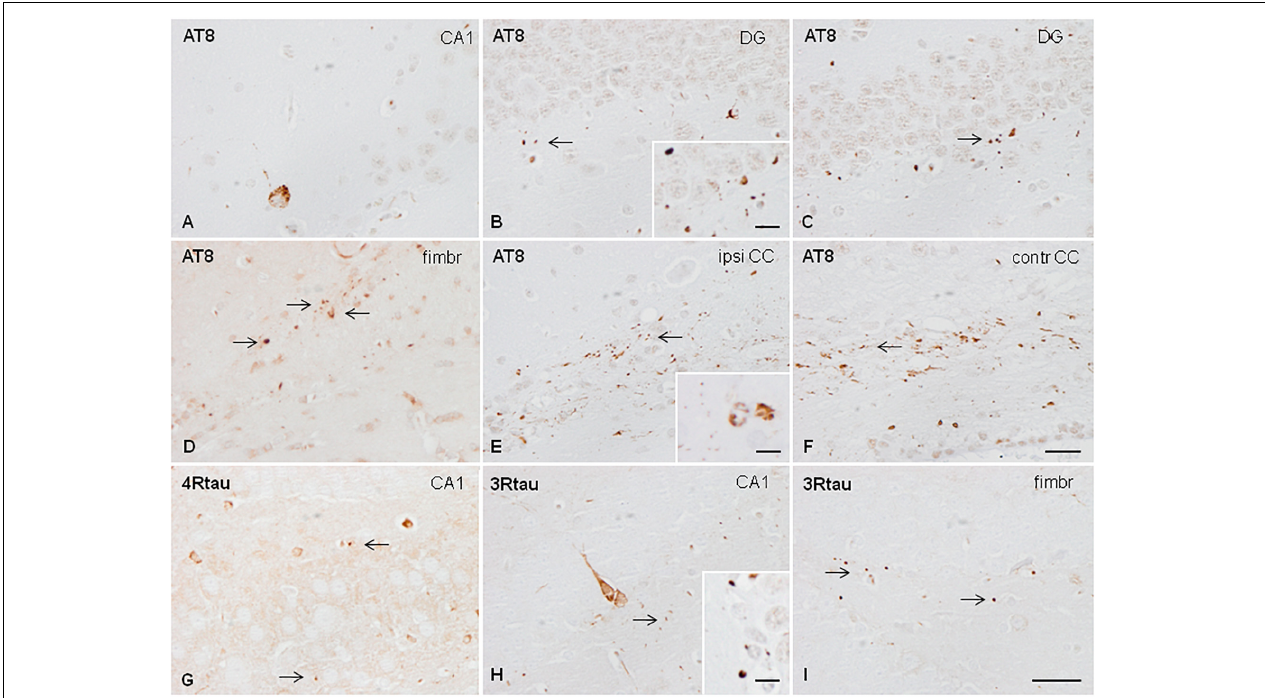
FIGURE 3 | Hyper-phosphorylated tau-containing cells and threads following unilateral hippocampal injection of sarkosyl-insoluble fractions from AGD in WT mice inoculated at 7 months and killed at the age of 10 months (3 months of survival) (A,B) ; inoculated at the age of 3 months and killed at the age of 6 months (3 months survival) (C) ; inoculated at the age of 12 months and killed at the age of 19 months (7 months survival) (D–F) ; and inoculated at the age of 3 months and killed at the age of 10 months (survival 7 months) (E–H) . Neurons in the ipsilateral hippocampus contain granular hyper-phosphorylated tau deposits as revealed with the AT8 antibody without morphological features of tangles (A) ; these deposits are stained with antibodies against 4Rtau and 3Rtau (G,H) . Grains (dots) in CA1 region of the hippocampus, dentate gyrus, fimbria, and corpus callosum are recognized with the antibody AT8 (B,C,E,F) , anti P-tau Ser262 (D) , and antibodies against 4Rtau and 3Rtau (G–I) (thin arrows). Threads and coiled bodies containing hyper-phosphorylated tau are seen in the ipsilateral and contralateral corpus callosum in mice surviving 7 months after inoculation. Paraffin sections slightly counterstained with hematoxylin. CA1, region of the hippocampus; DG, dentate gyrus; fimbr,